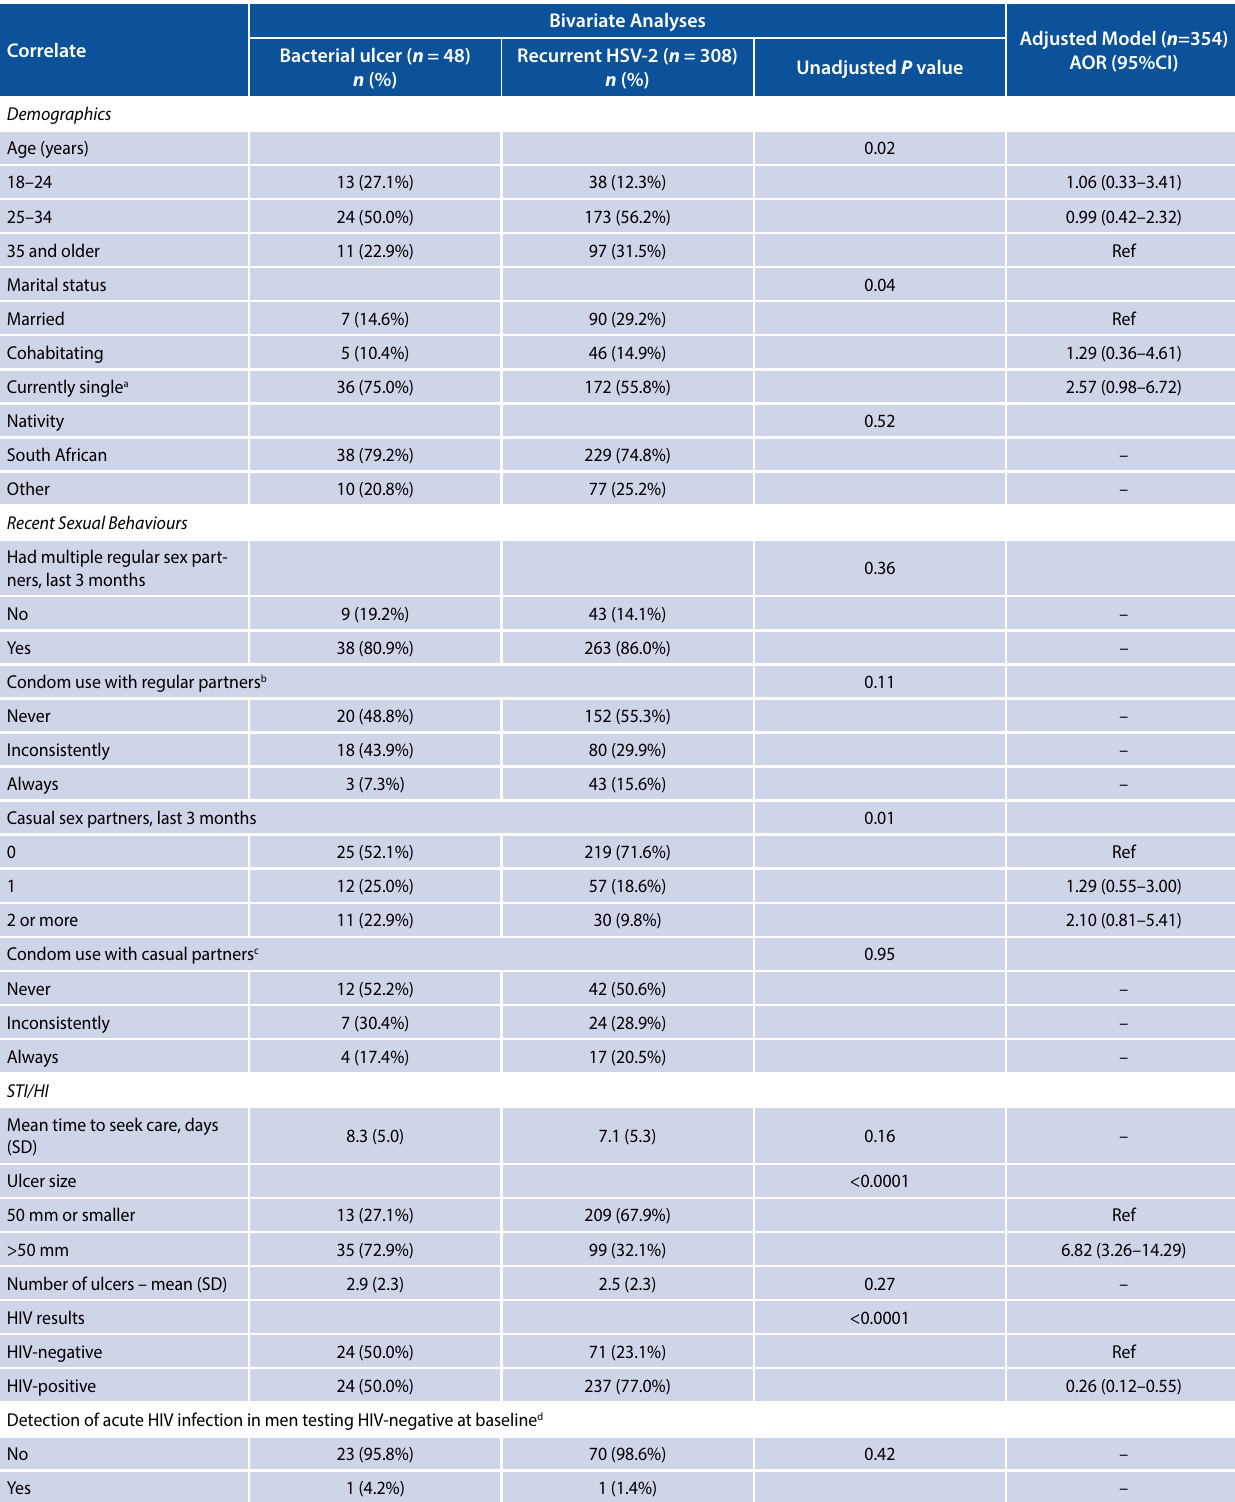
Table 1: Characteristics of men with bacterial ulcers as compared to recurrent HSV-2 ulcers, South Africa,